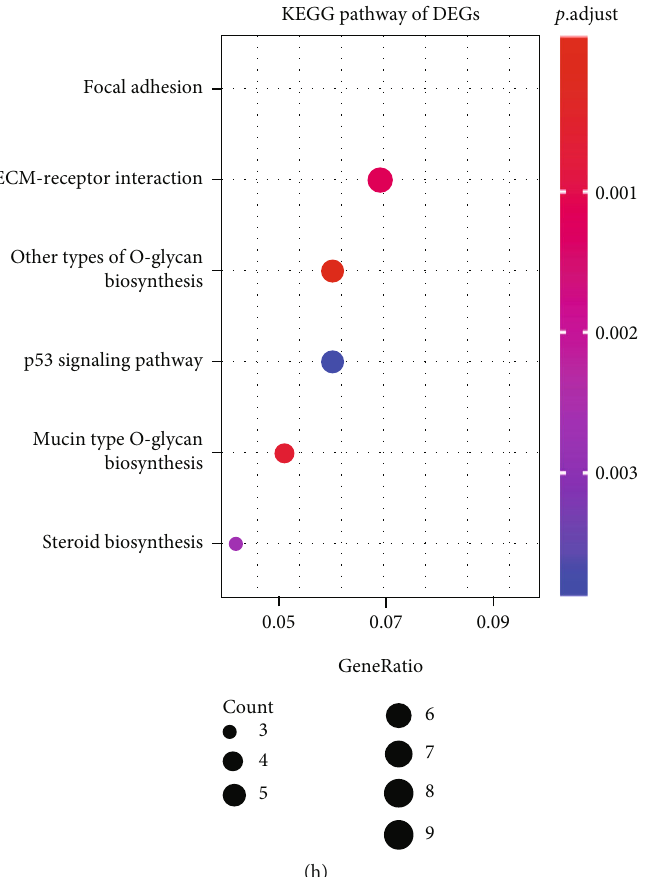
Figure 2: Functional enrichment analysis results of up- and downregulated genes for osteosarcoma. (a) Biological processes; (b) cell component; (c) molecular function; and (d) KEGG for up-regulated genes. (e) Biological processes; (f) cell component; (g) molecular function, and (h) KEGG for downregulated